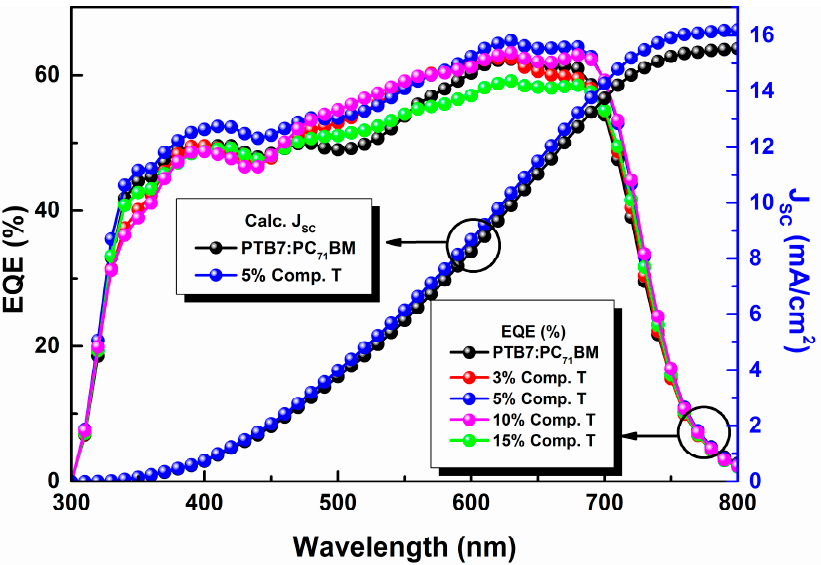
Figure 6. External quantum efficiency (EQE) curves of the reference (black), 3% (red), 5% (blue), 10% (violet) and 15% (green) compound T based OSC devices.